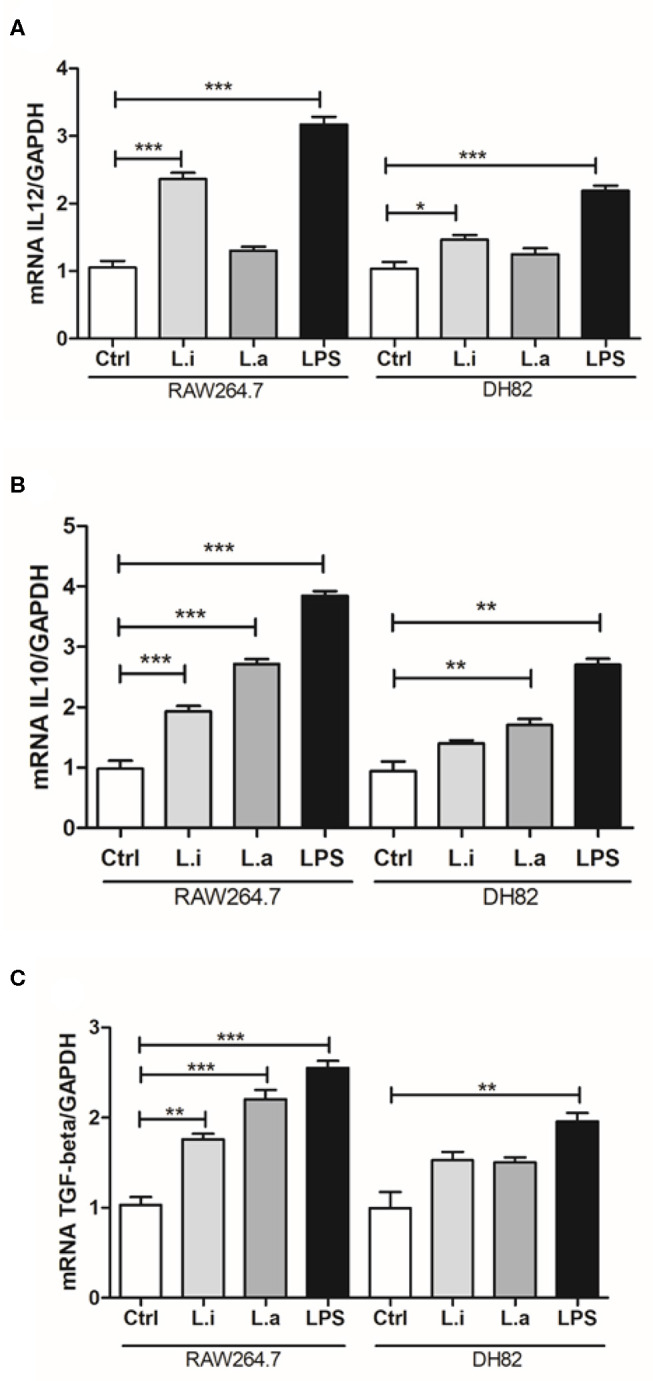
Cytokine profile in Leishmania-infected canine (DH82) and murine (RAW264.7) macrophages. Macrophages were stimulated or not (Ctrl) with 1 μg/mL of LPS or infected with L. amazonensis or L. infantum. After 24 h of infection, the cells were processed and mRNA for the cytokines quantified by qRT-PCR. Data from the experiments were normalized using GADPH primers as an endogenous control. LPS was used as positive control. Data from triplicate are expressed as means ± SEM. *p < 0.05; **p < 0.01; ***p < 0.001.